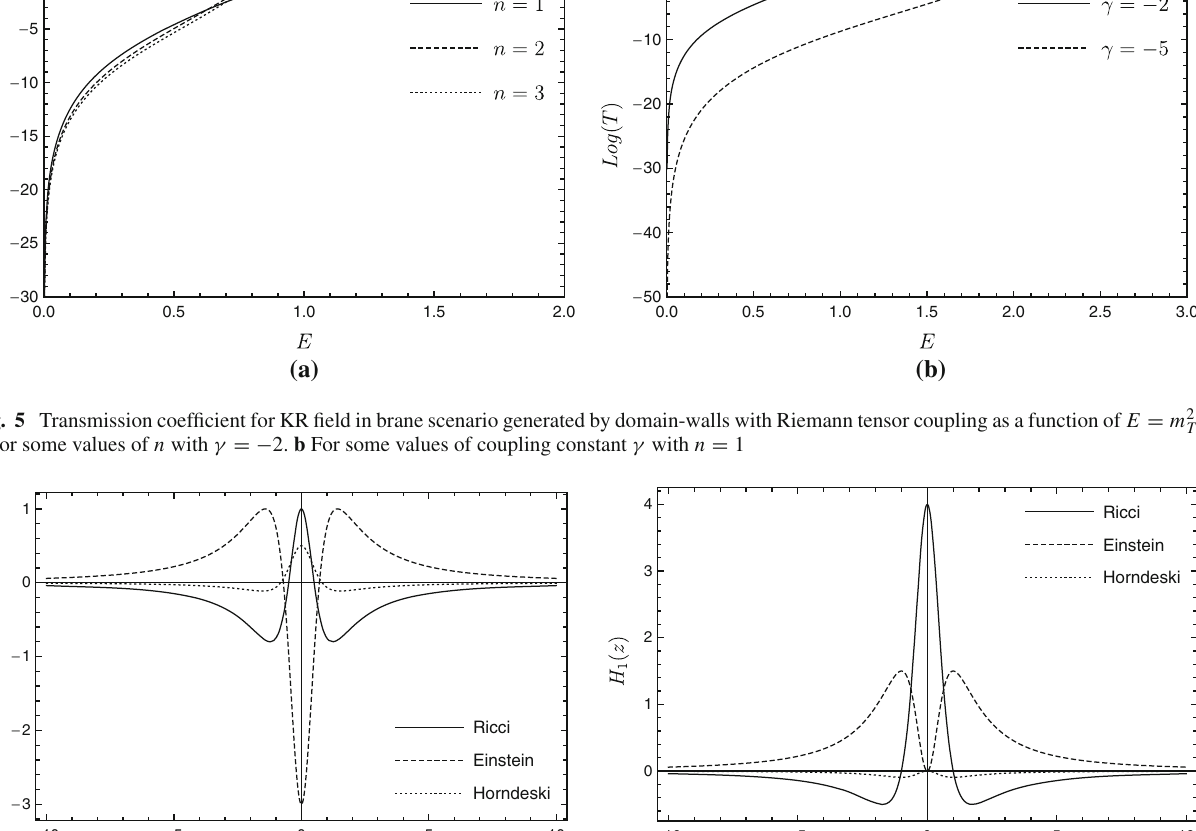
Fig. 6 The components H 0 and H 1 in smooth scenario generated by domain wall with n = 1 for the Ricci, Einstein and Horndeski tensors. a H 0 and b H 1